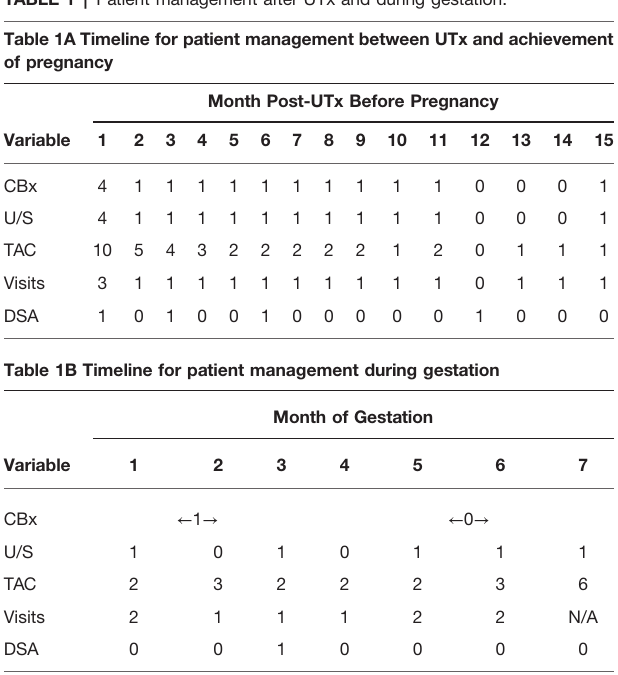
CBx, Cervical Biopsy; U/S, Ultrasound; TAC, Tacromilus; DSA, Donor Speci fi c Antibodies. Fetal heart monitoring from 29 weeks of